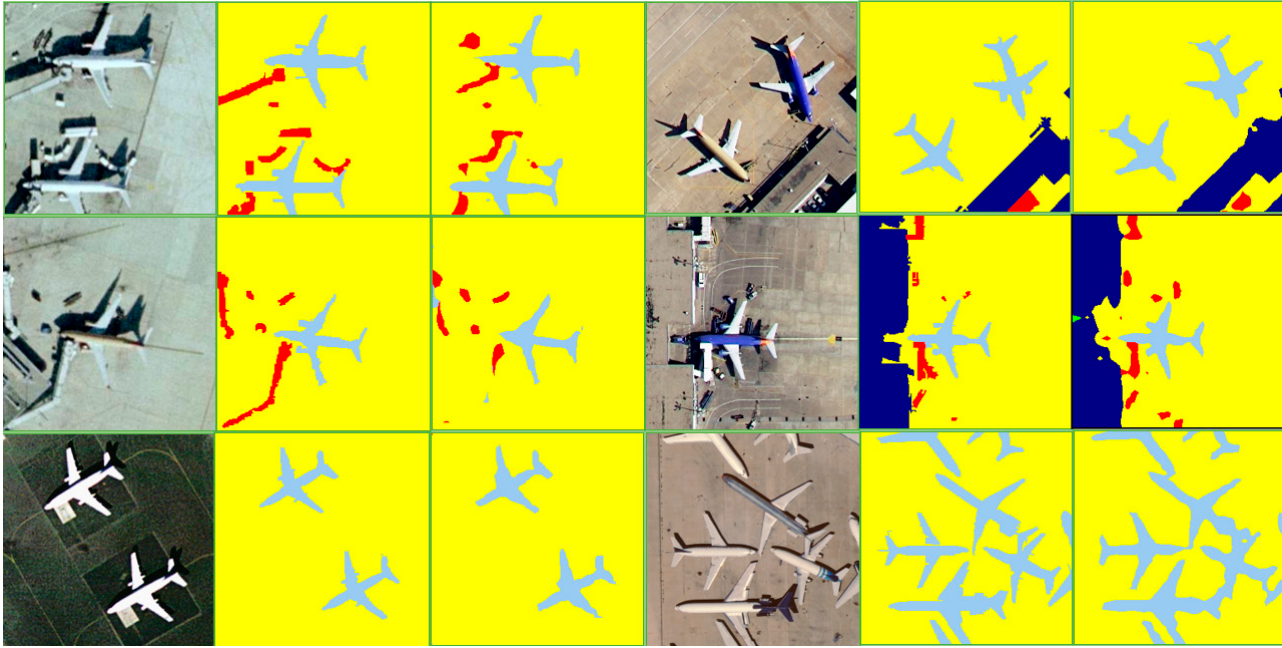
Figure 6. Examples of semantic segmentation results from the DLRSD, (from left to right are: the original image, the ground truth, and the predicted images).